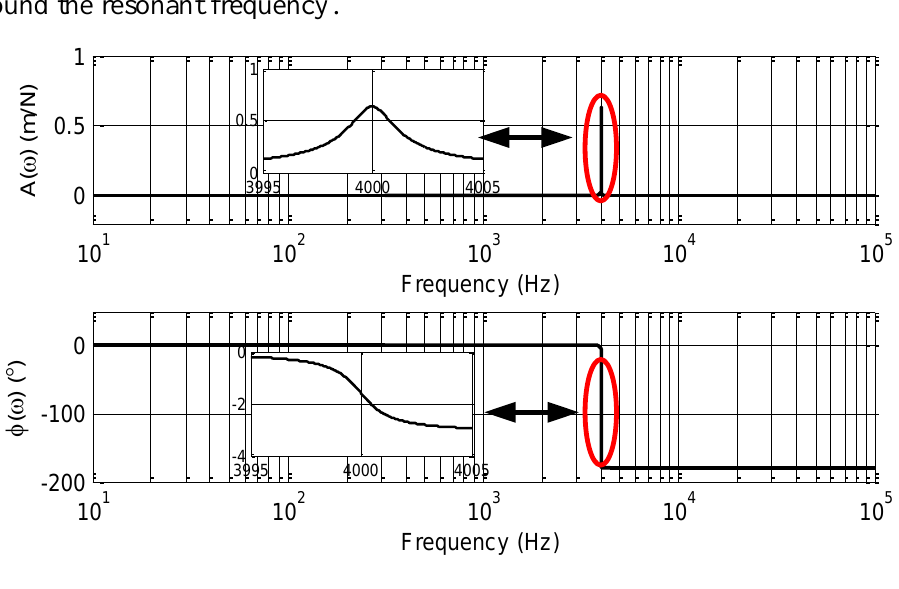
Figure 2. The magnitude and phase transfer function plot, with the inset showing a detailed view around the resonant